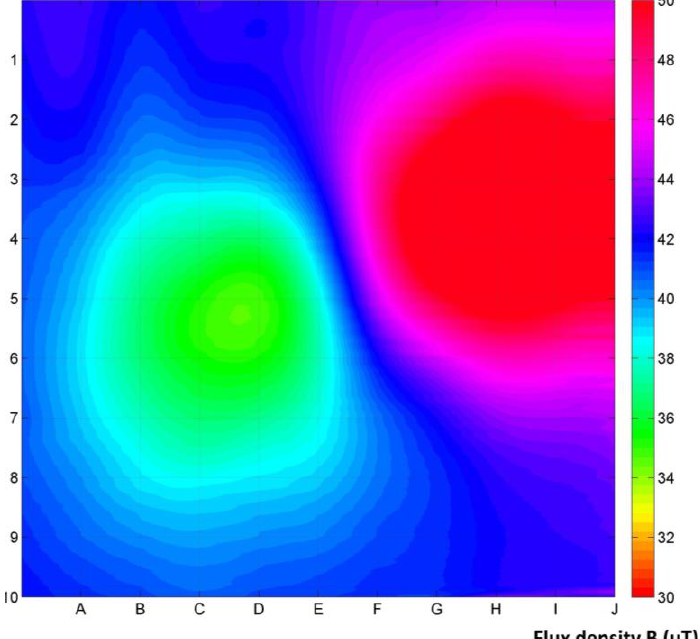
Figure 4. Visualization of the distribution of the magnetic induction vector absolute values, with the magnetic background intact. In addition to positive and negative disturbances, the Earth’s magnetic field can be